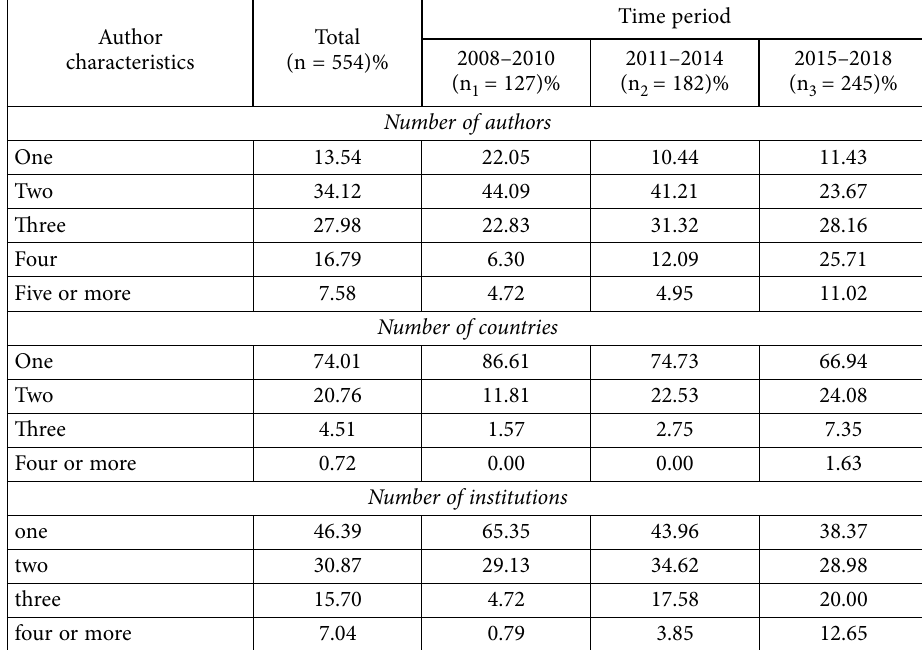
Table 2. Author characteristics of the TEDE publications Author